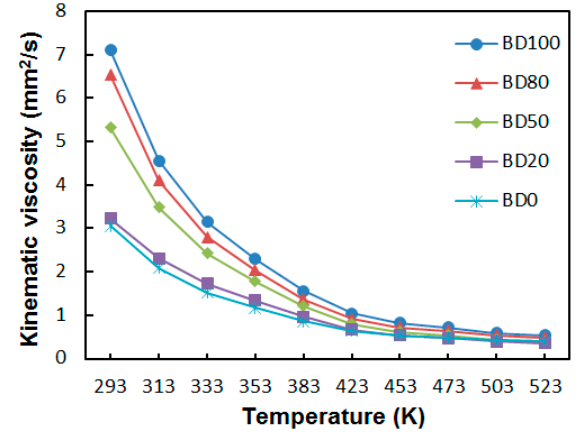
Figure 7. The viscosity change of canola oil biodiesel blended with diesel fuel at different temperatures.